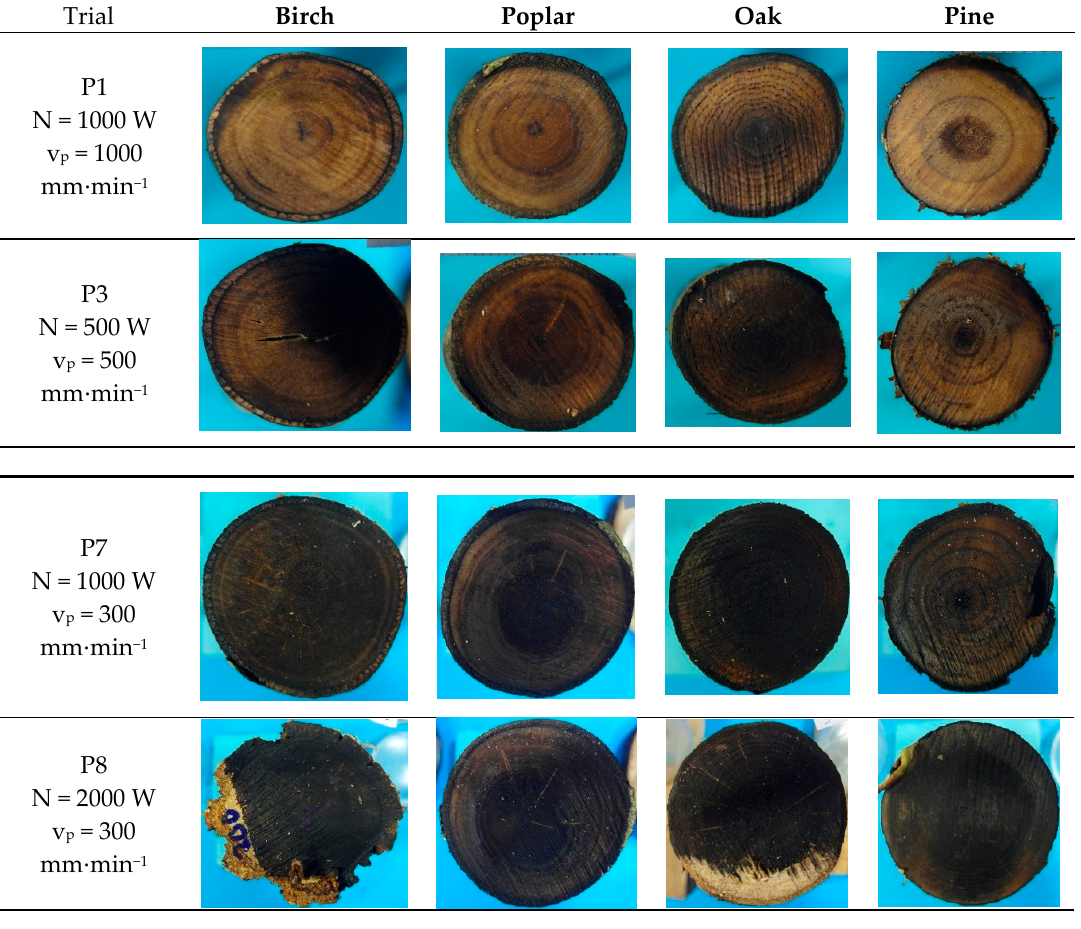
Figure 3. Cut surfaces at different laser beam powers and travel speeds.